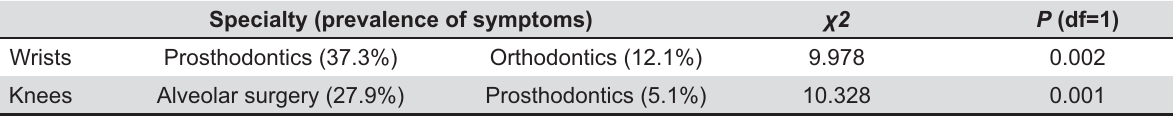
Table 2- Inter-specialty comparison of prevalence of wrist/knee MSDs